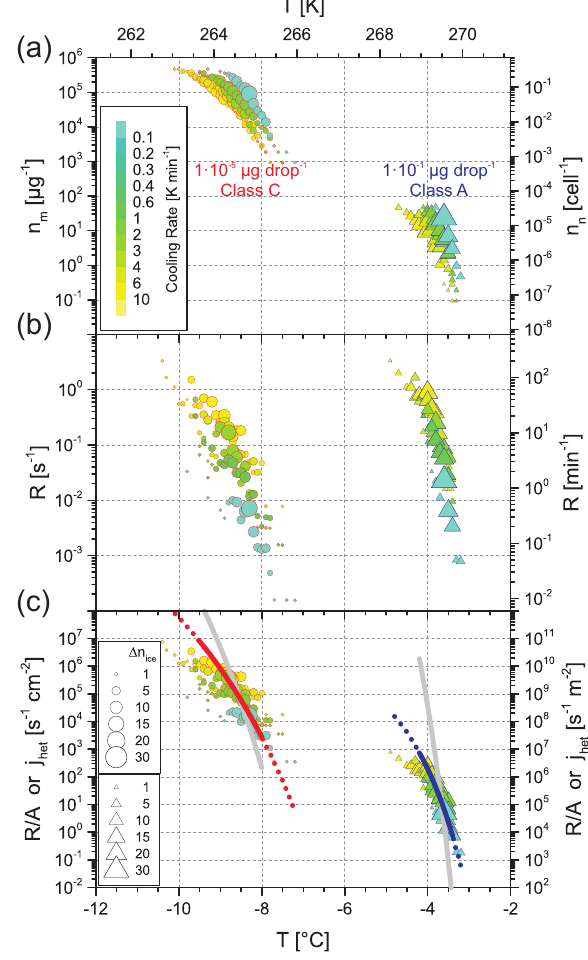
Figure 6. (a) Cooling rate dependence of the active site densities per mass ( n m (T ) ) and per cell ( n n (T ) ) vs. temperature for two classes of INs determined from droplets containing the indicated Snomax ® concentrations. (b) Stochastic analysis of the data from (a) in terms of the nucleation rate R(T ) . (c) Normalized nucleation rate R(T )/A data derived from the R(T ) data in (b) following Eq. (6) (data points) and analysis of these data in terms of the heterogeneous ice nucleation rate coefficient j het (T ) using CNT with a constant effective contact angle α (gray lines) and a linear temperature de- pendence of α (colored